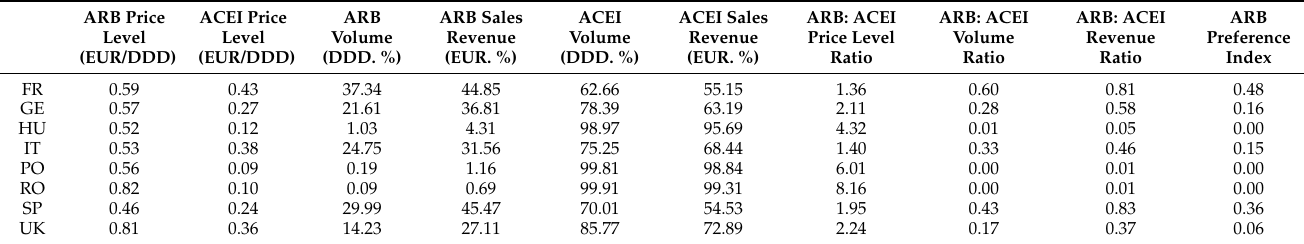
Table 1. Market features of ARBs and ACE inhibitors in 2001 based on DDD-adjusted volumes, taking into consideration combination drugs and single-drug preparations.